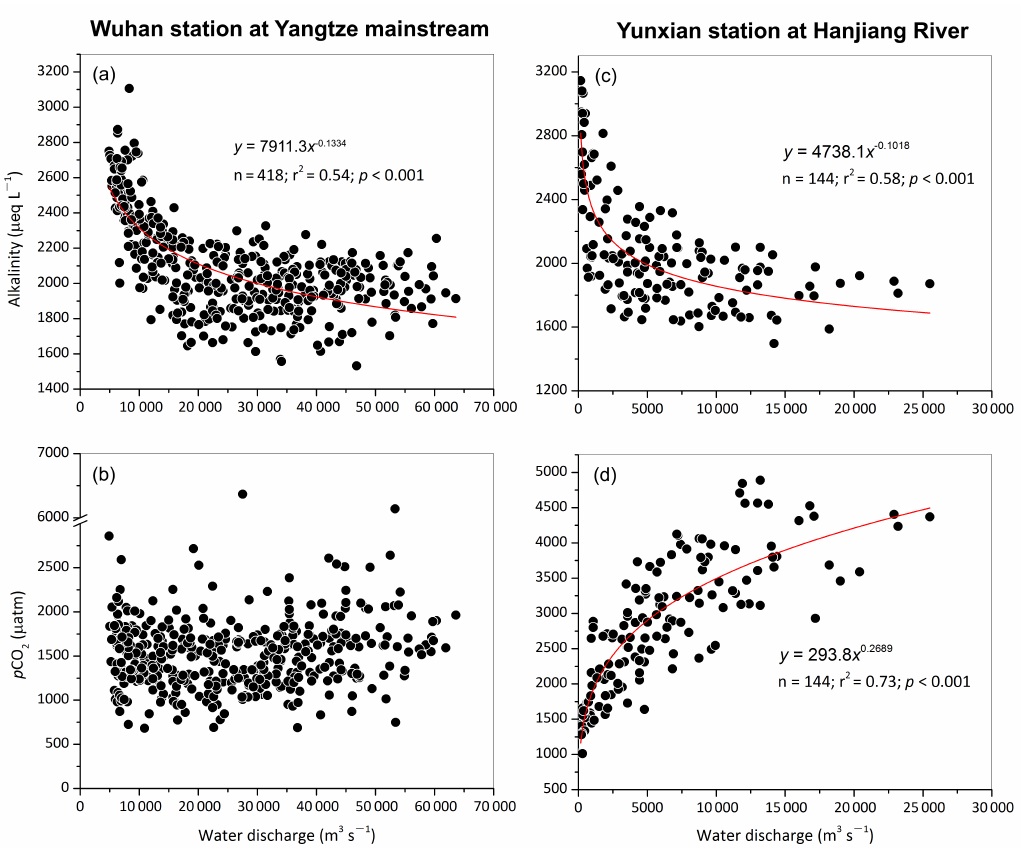
Figure 5. Correlations between water discharge and instantaneous alkalinity and p CO 2 : the mainstem at Wuhan station (a, b) and the Hanjiang River at Yunxian station (c, d)